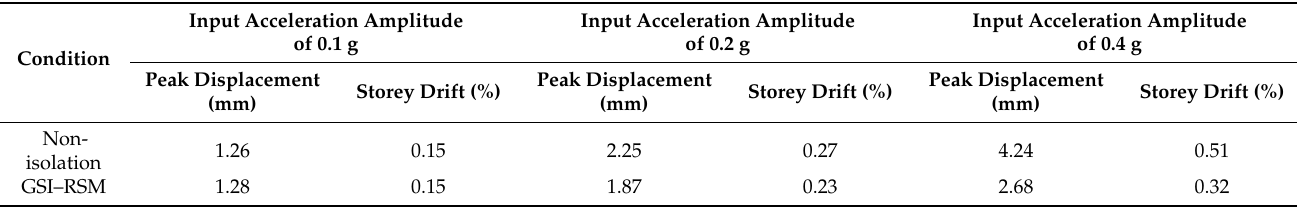
Table 5. Peak displacement and storey drift of